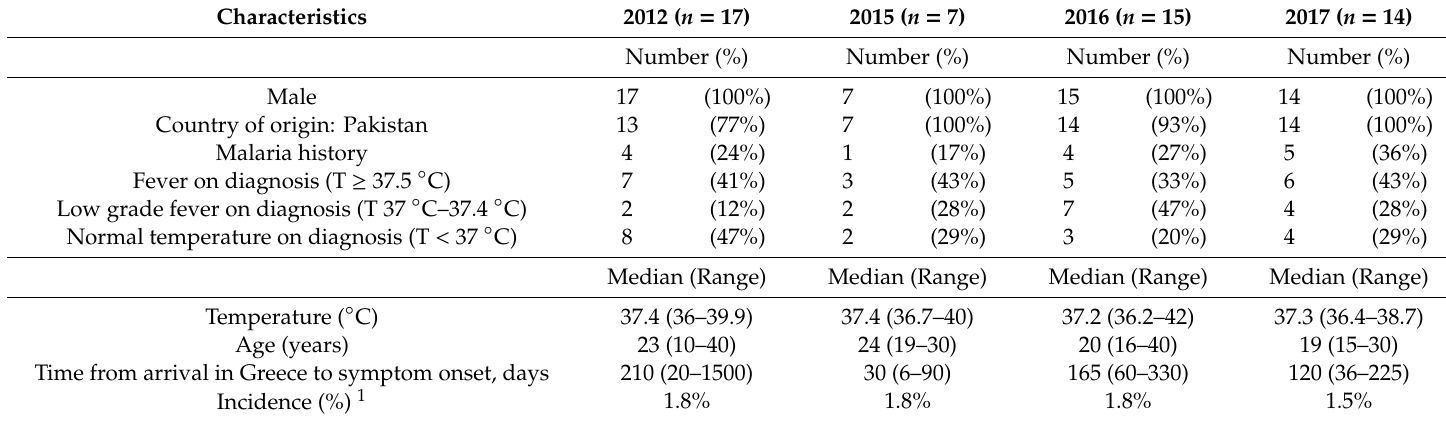
Table 5. Characteristics and incidence of imported malaria cases, Evrotas Municipality,